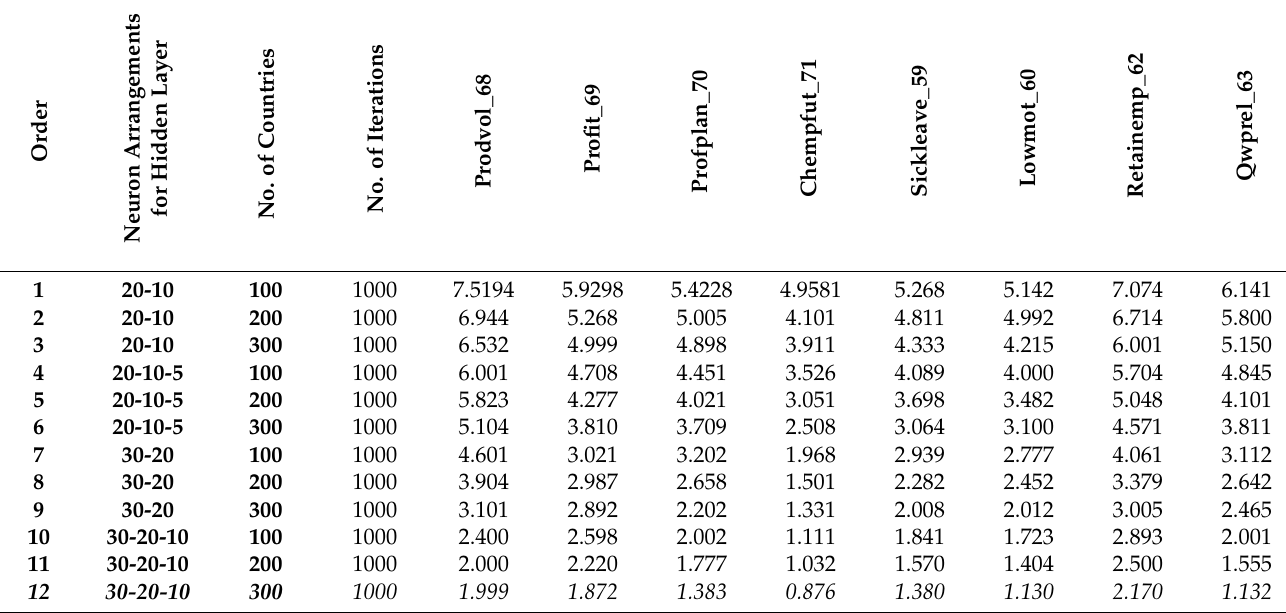
Table 4. Training MAPE for the effect of the external environment on